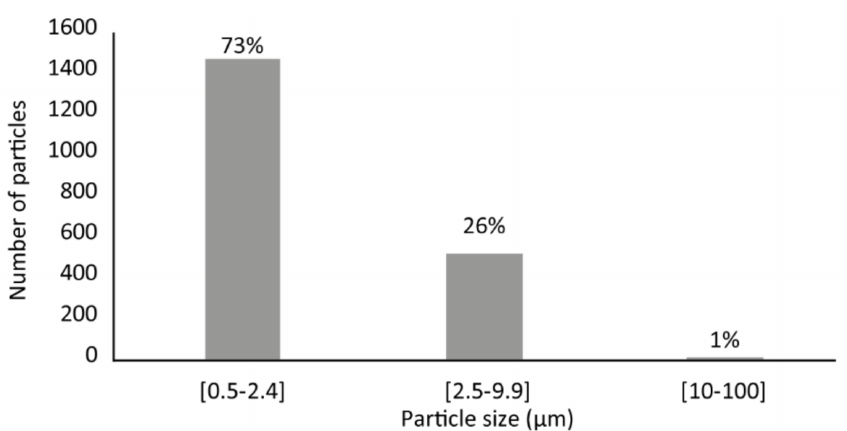
Figure 3. Size distribution of the atmospheric particles detected in the SEM—EDX